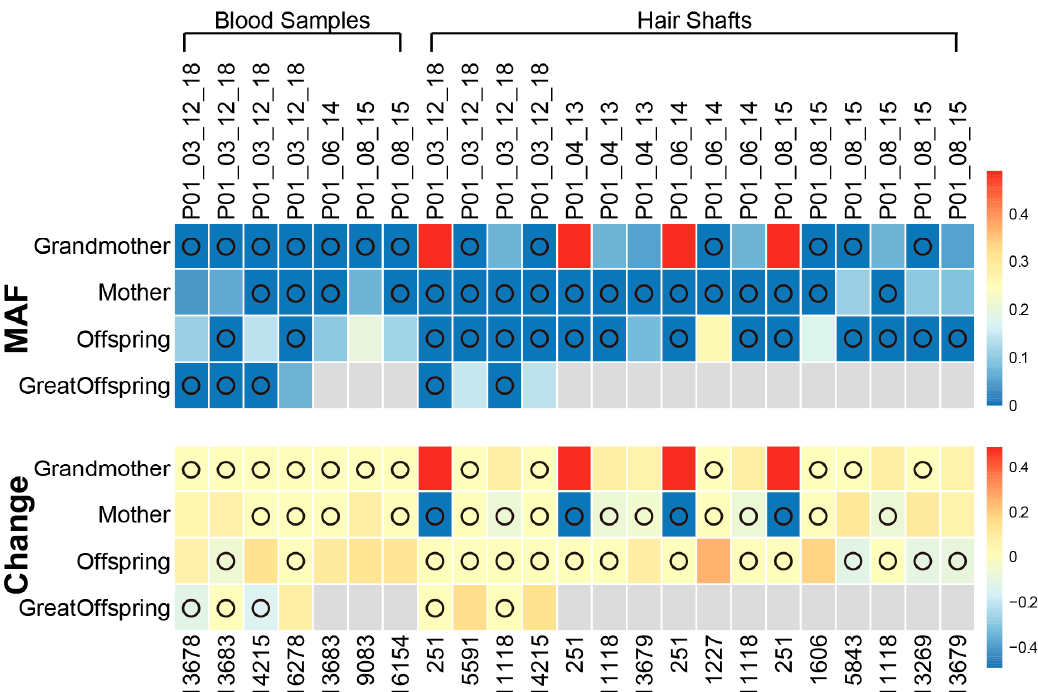
Figure 9. PHP and MAF changes during transmission. The top panel shows the MAF of the PHP for each sample. The bottom panel shows the MAF changes during transmission. A circle indicates that the heteroplasmy disappeared in the sample.